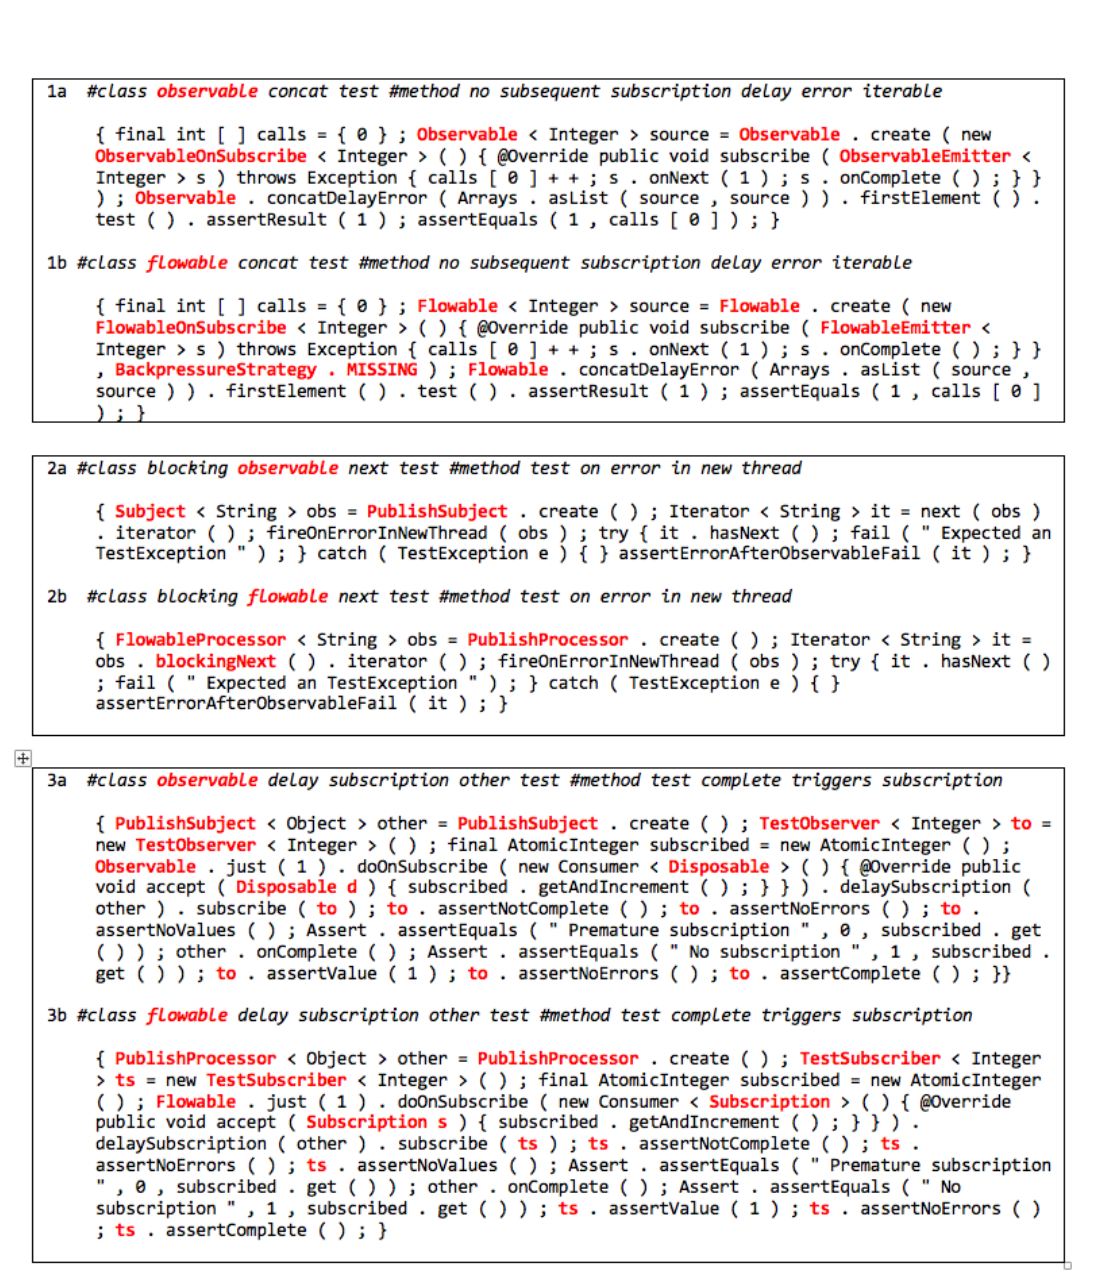
Figure 4. Examples of functions written to validate analogous behavior of Observable (1a, 2a, 3a) and Flowable (1b, 2b,